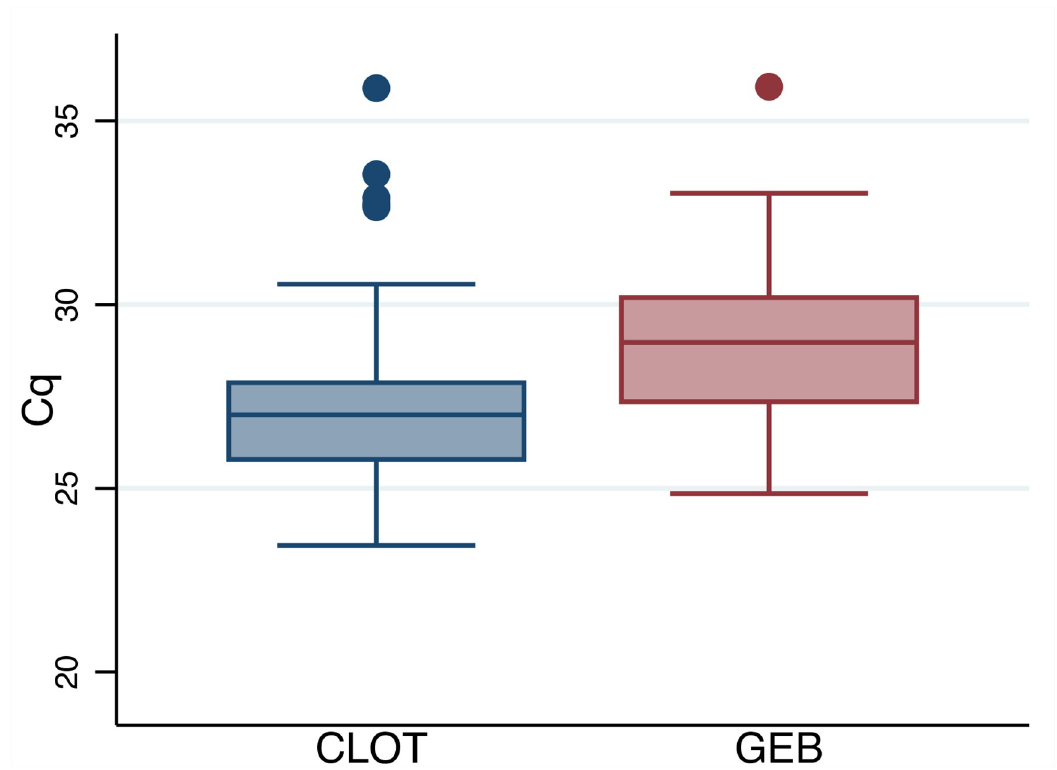
Fig 1. Distribution of Cq values in GEB and clot samples. The line inside the box represents the median, and the box comprises the lower and upper quartiles. The mean Cq for clot samples (extracted using the new technique) was 27.32 [95%CI: 26.69–27.95]. The mean Cq for GEB samples was 29.02 [95% CI: 28.36–29.67] ( P = 0003 ). Agreement between the two samples was 95.9% (Kappa = 0.8483). Out of the five samples that tested positive in the clot extracted DNA with a Cq value greater than 32, three were also positive on the qPCR using DNA from GEB